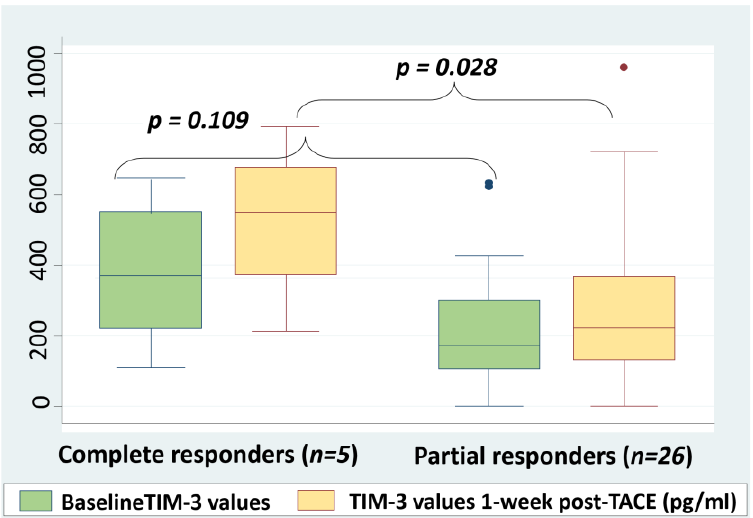
Figure 4. Pre- and post-TACE sTIM-3 values according to treatment response based on Modified Response Evaluation Criteria in Solid Tumors (mRECIST) criteria. Mann–Whitney U test was applied to compare sTIM-3 values. Outliers were excluded from the analysis. sTIM-3; serum T-cell immunoglobulin and mucin domain-3, TACE; transarterial chemoembolization.